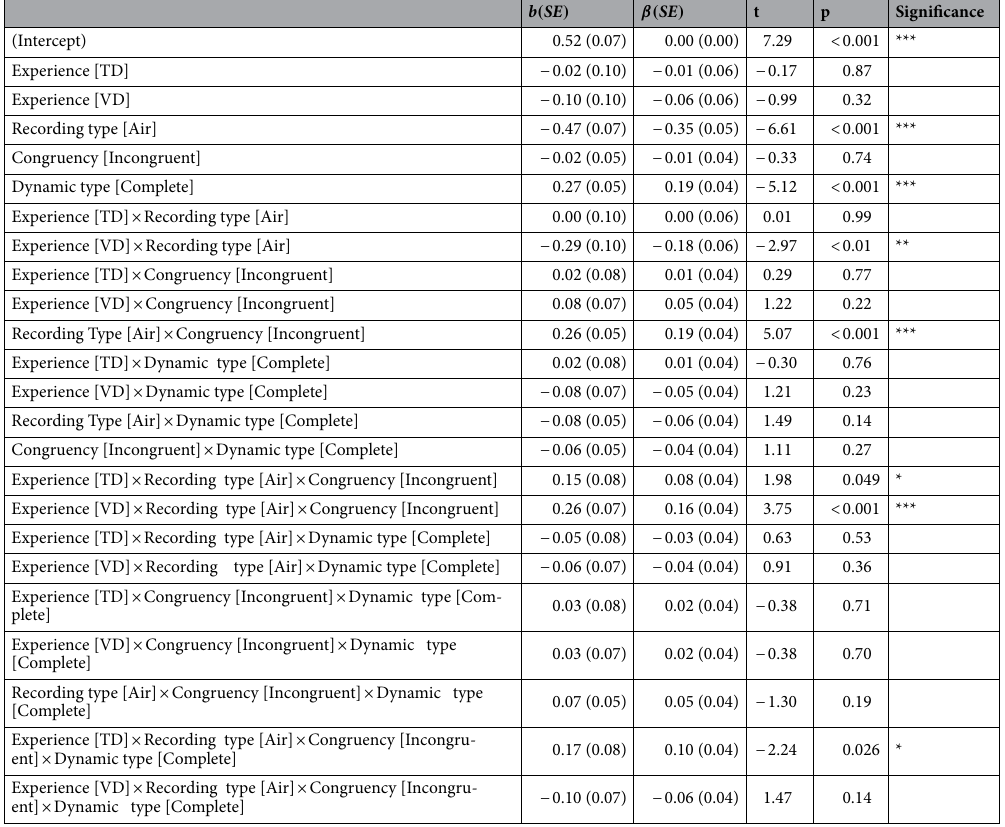
Table 2. Results of the LMM Model, including the unstandardized ( b ) and standardized ( β ) slopes, and